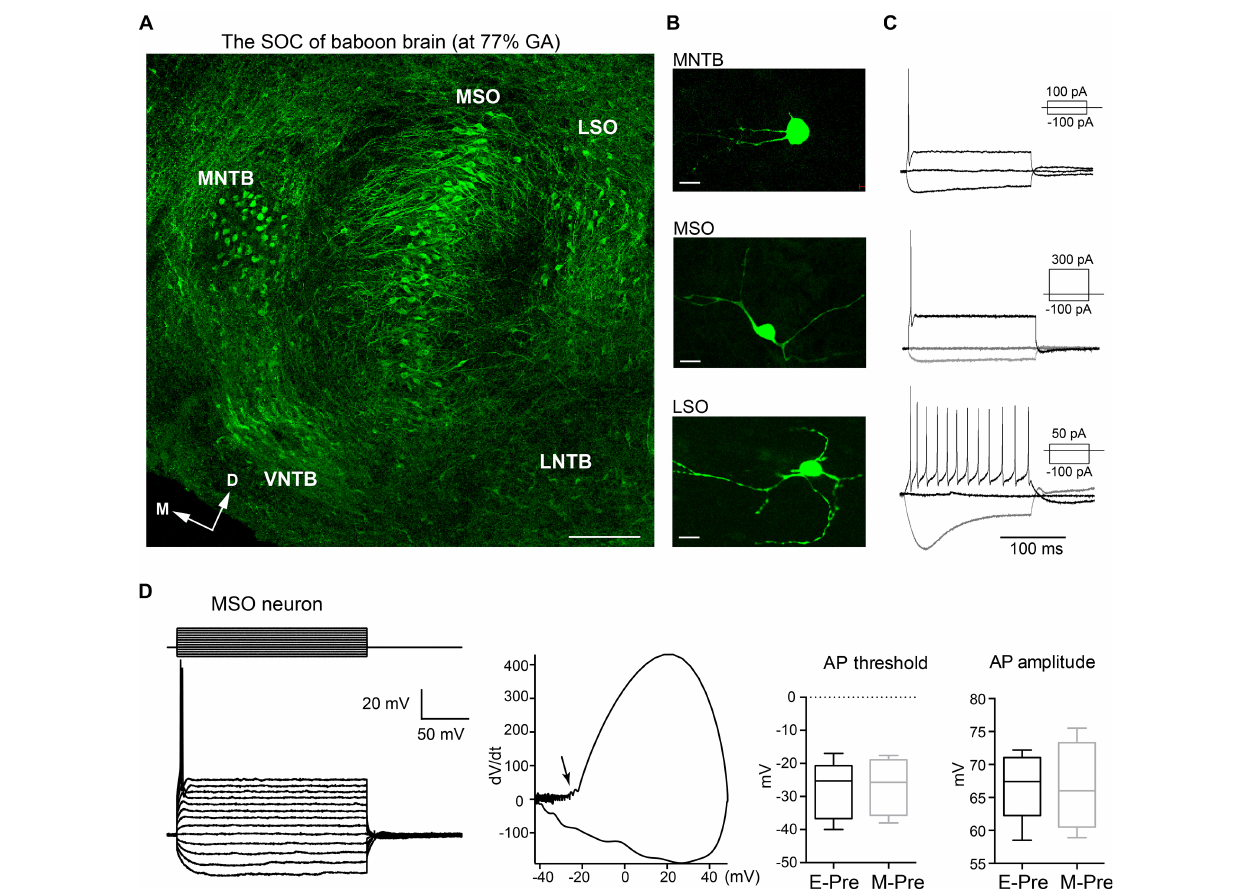
FIGURE 1 | The main nuclei of the baboon SOC. (A) The SOC in the auditory brainstem from a baboon neonate delivered at 77% GA (moderate preterm; M-Pre), immunolabeled with MAP2 (green). From the midline of the brainstem, the MNTB, MSO, and LSO were arranged in a lateral direction. Scale = 200 µ m. (B) Individual cells from LSO, MNTB, and MSO nuclei were filled with Alexa dye during whole-cell recordings. Scale = 50 µ m. (C) Representative trace of membrane potentials of individual neurons. Action potentials from the same cells in B were evoked by threshold current injections. Inset, depolarizing and hyperpolarizing current injections. (D) Representative trace of membrane potentials of MSO neuron from a M-Pre neonate in response to prolonged current injection (from –200 pA to 400 pA, (cid:49) 50 pA for 200 ms) at holding –70 mV. (Middle) Phasic plotting of a single AP (dV/dt against membrane voltage) triggered by current injection (300 pA). Arrow indicates the AP threshold. (Right) The AP threshold and amplitude of MSO neurons from extreme preterm (E-Pre) and M-Pre baboon neonates. In box and whisker plot, boxes indicate 25–75% interquartile range and horizontal lines in boxes indicate median.